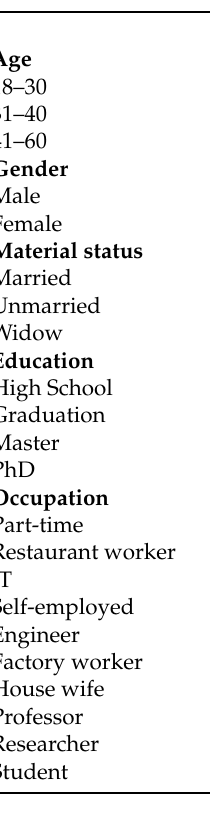
Table 1. Participant